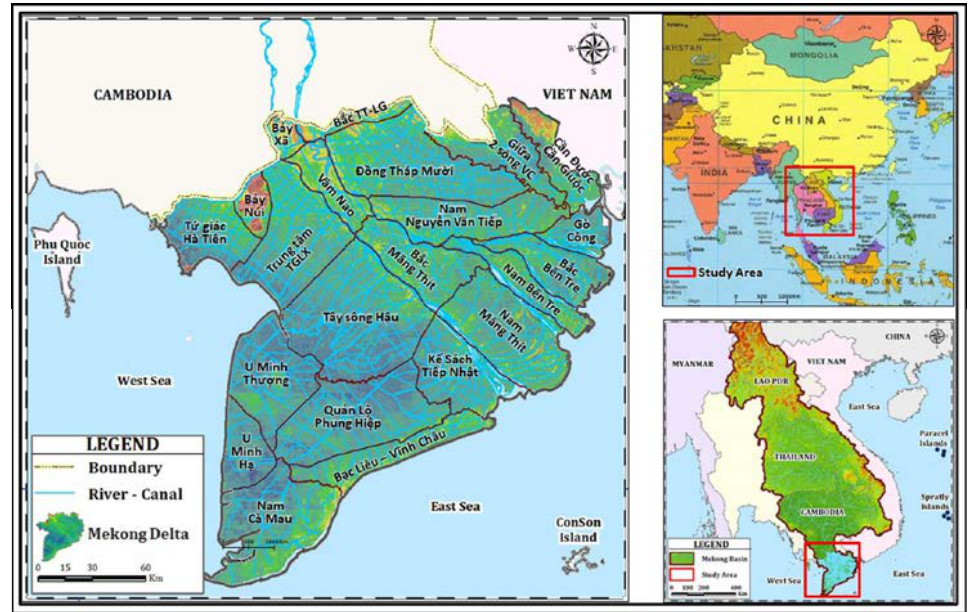
Fig. 1: Geographic location of the study area in the Mekong Delta in Vietnam